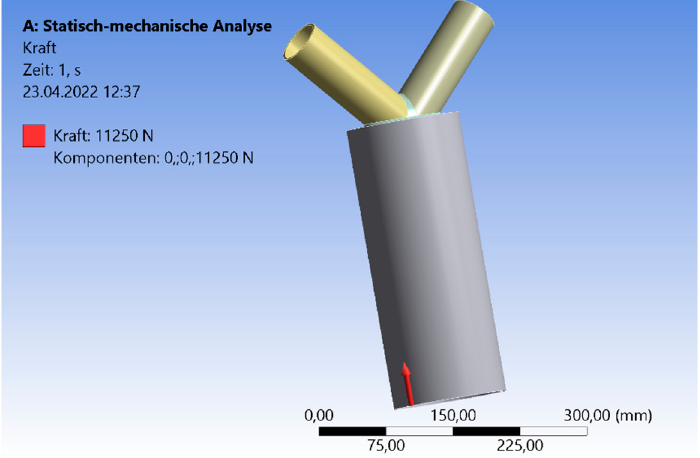
Figure 1. System and Load case